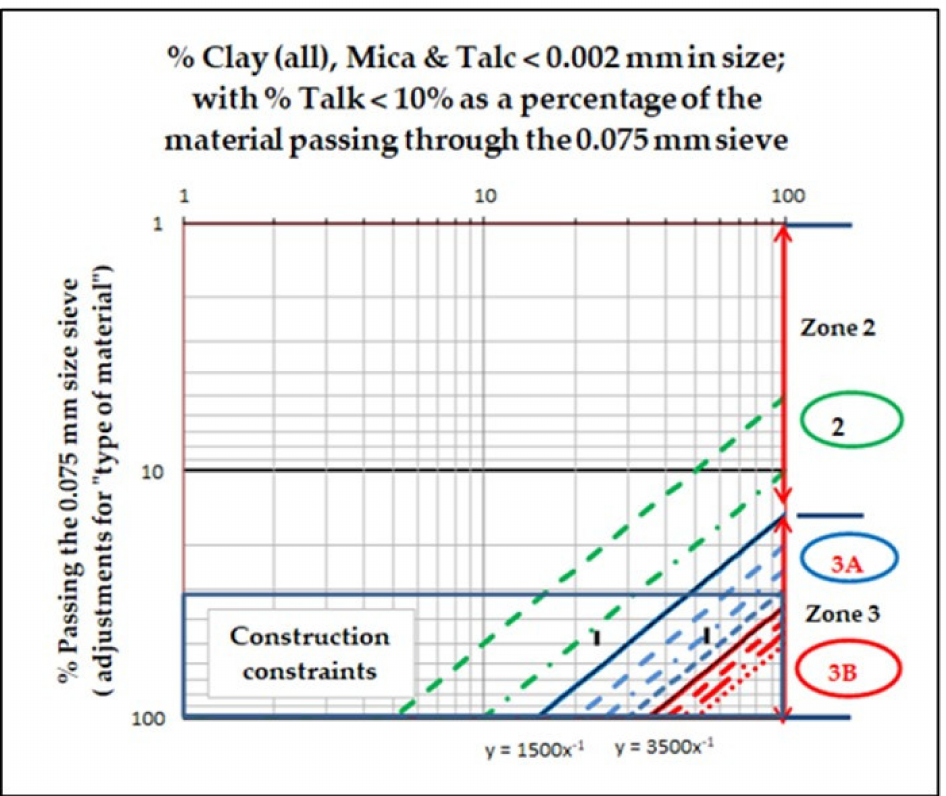
Figure 22. Materials with a high percentage of fines as demarcated, indicating materials which may present challenges in terms of construction practices in the